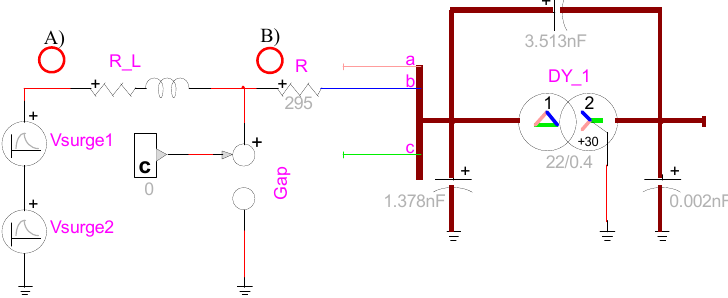
Figure 9. Placement of the proposed filtered spark gap, EMTP-RV model.